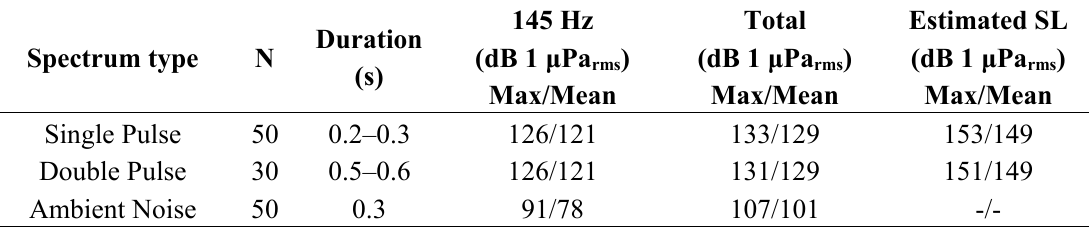
Table 1. Summary of WEC and ambient noise measurements. Shown are number